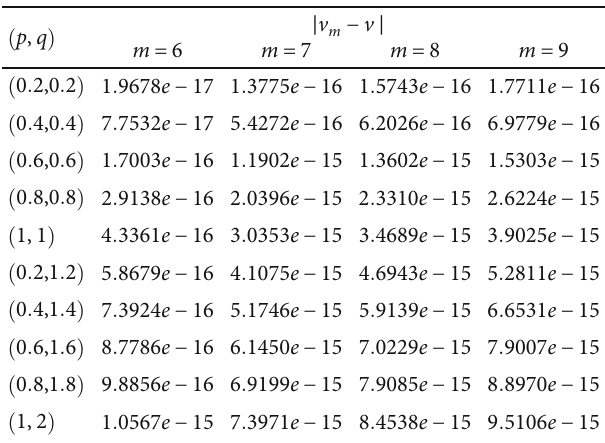
Table 5: The absolute error for di ff erent values m for Example 8 at various points ð p , q Þ .